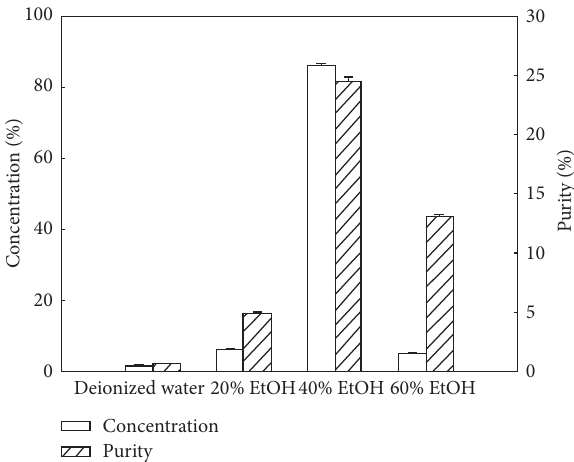
Figure 4: The result of purification of BKBA by preparative chromatography.